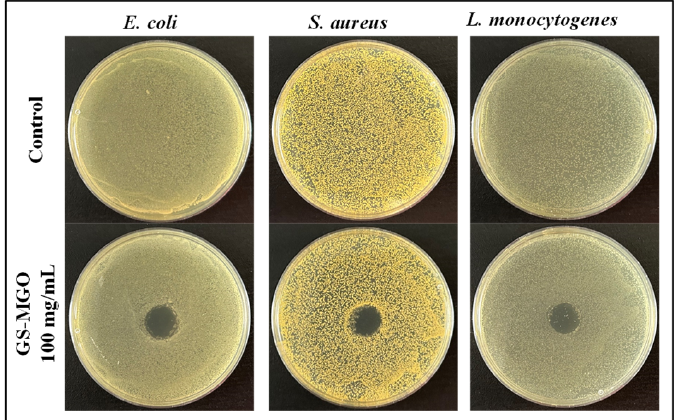
Figure 4. The inhibition zones of GS-MGO against E. coli , S. aureus, and L. monocytogenes .